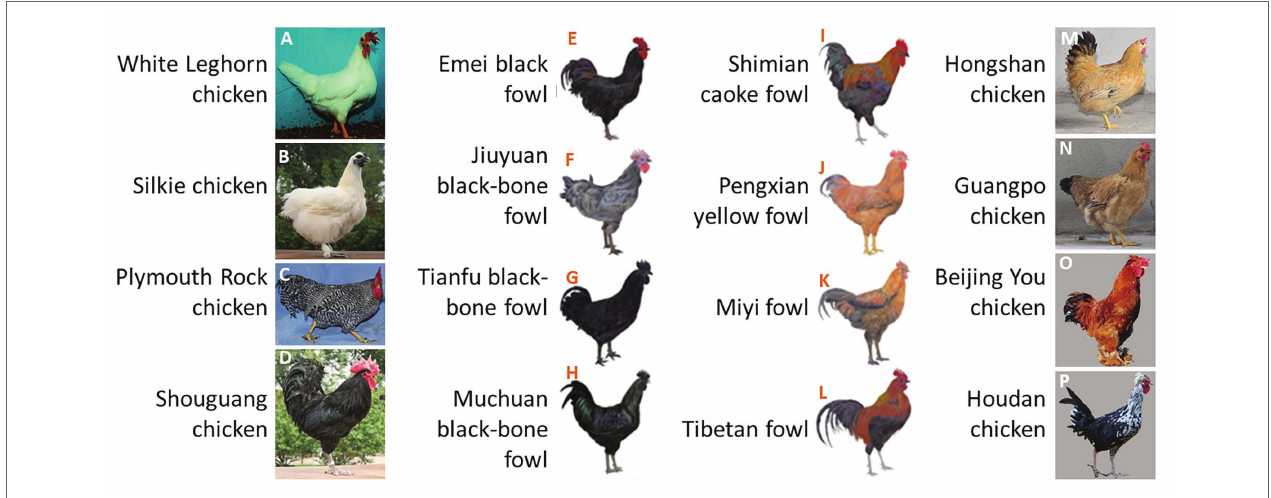
FIGURE 1 | Chicken feather color. (A–H) Body feather color is consistent with tail feather color; (I–P) body feather color is different from tail feather color. Image Source: (A) Kerje et al. (2004), (B,D) Feng et al. (2014), (C) Hellstrom et al. (2010), (E–L) Li et al. (2019), (M,N) Wang et al. (2017), and (O,P) Zhang et al.